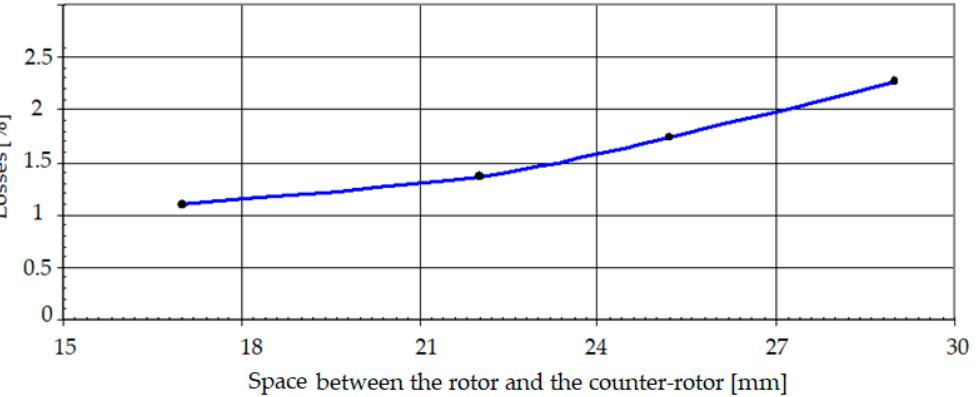
Figure 8. The variation of losses ( p ) depending on the space between the rotor and counter-rotor ( δ ). Examining the variation in losses, they are inversely proportional to the space between